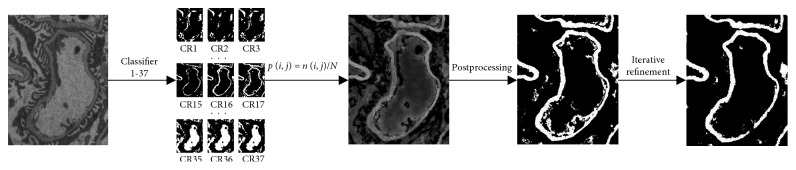
Segmentation process of RFS2.